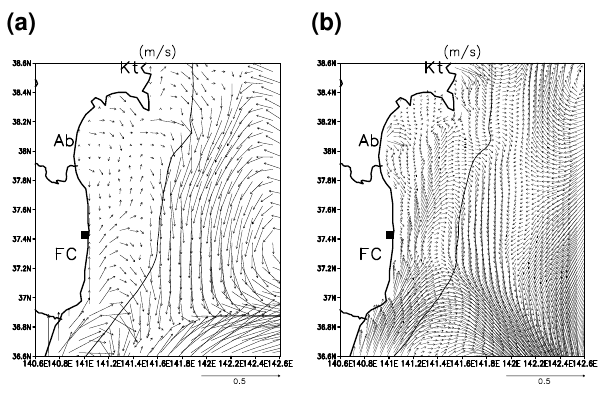
Fig. 1. Simulated ocean current at 1m depth averaged for the pe- Figure 1 riod from 21 March 2011 to 6 May 2011. A thick line denotes an isodepth contour showing 200m depth. A closed square indicates the position of FNPP. Abbreviations “Ab”, “Kt”, and “FC” indicate the river month positions of the Abukuma and Kitakami rivers, and Fukushima coast, respectively. (a) JCOPE2 (b)